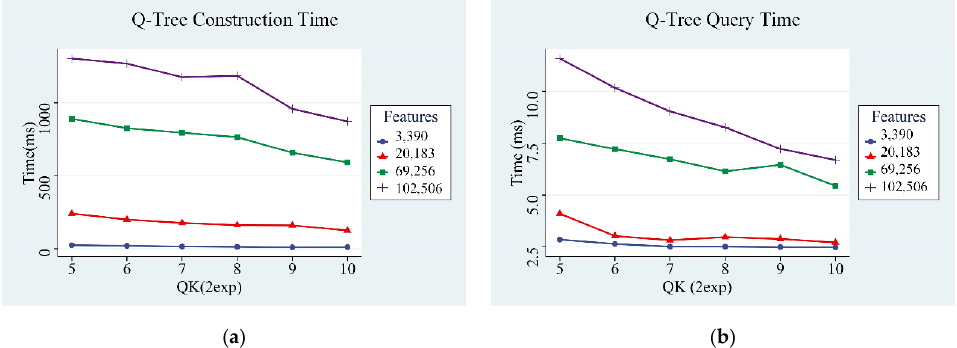
Figure 9. The construction time and query time of quadtree. ( a ) The construction time of Quadtree; ( b ) The query time of Quadtree.